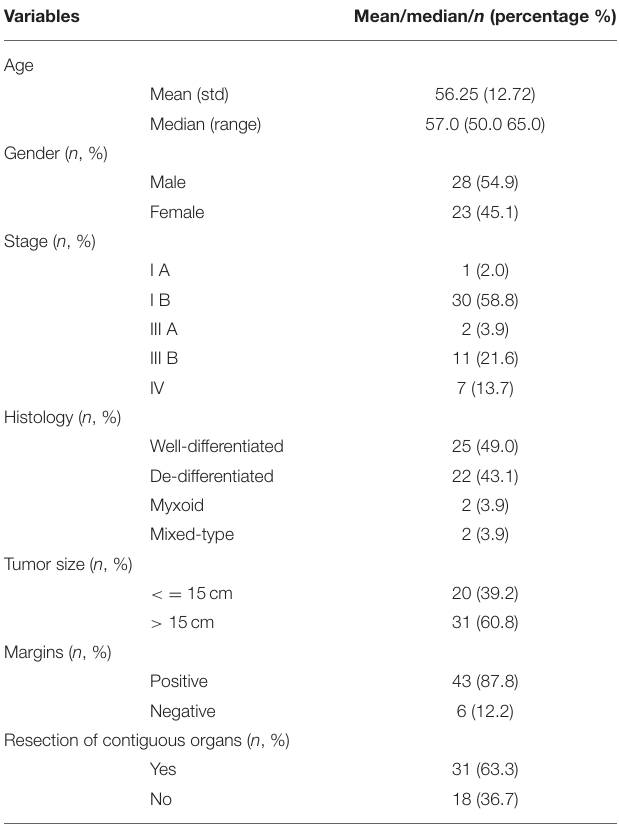
TABLE 1 | Clinico-pathologic and treatment characteristics in patients with primary liposarcoma of the retroperitoneum. Variables